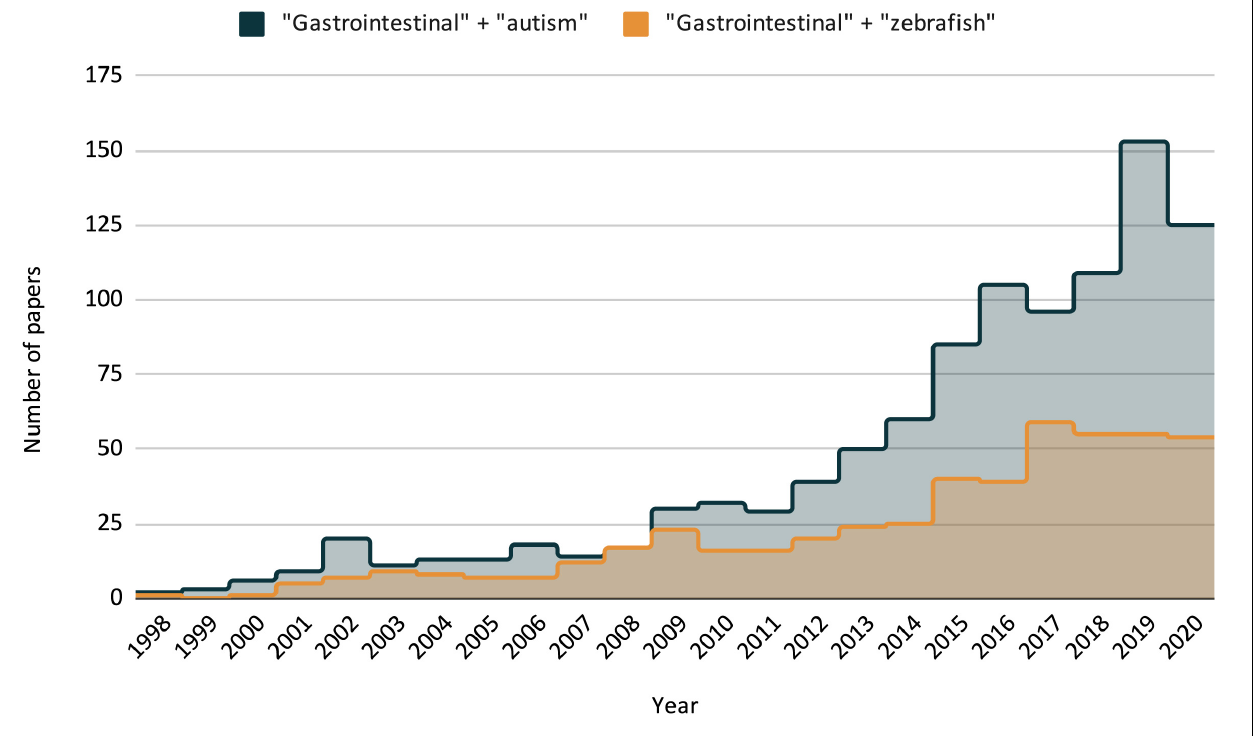
FIGURE 1 | Publication trends as listed by PubMed/NLM over the last two decades, search criteria for each is “gastrointestinal + autism” and “gastrointestinal + zebrafish.” Including all three search terms (GI + ASD + zebrafish) only resulted in three publications, the earliest in